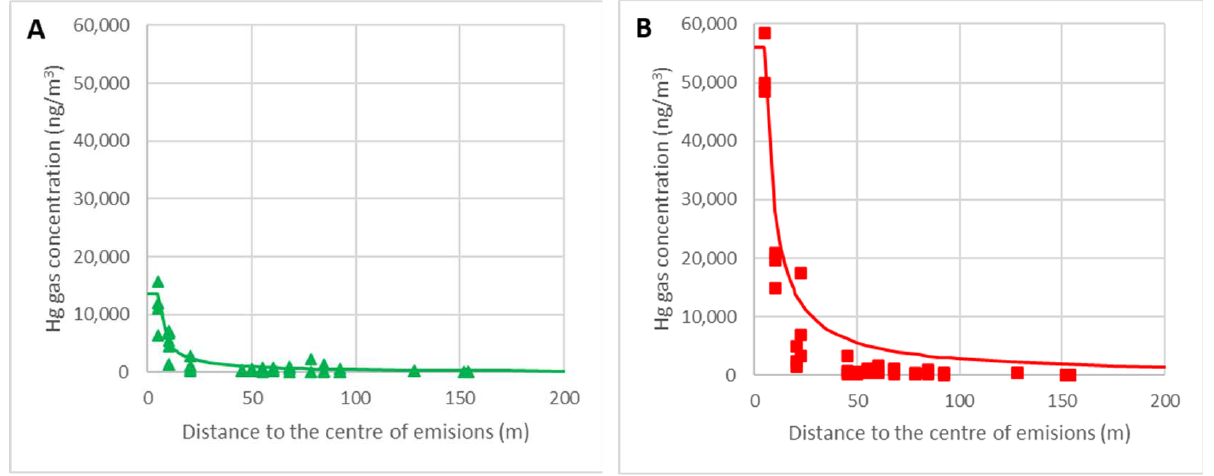
Figure 3. Relationship between temperature and concentration at points 9 ( A ) and 10 (B).